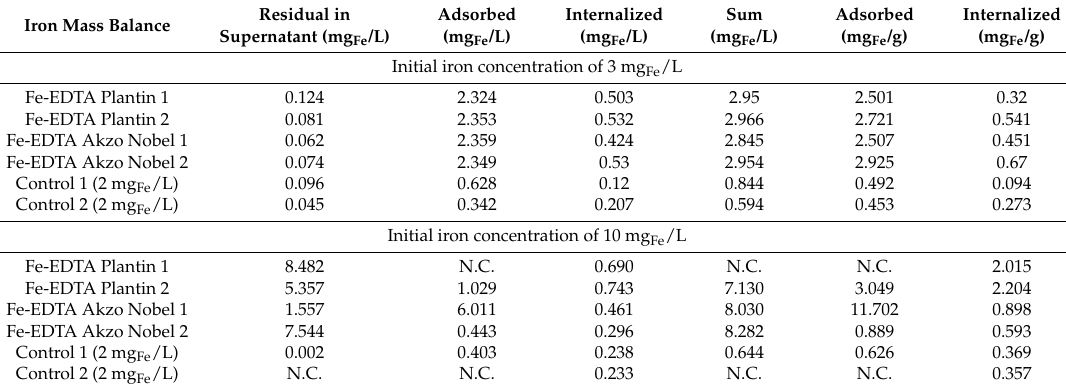
Table 4. Iron mass balance for the Spirulina cultivation experiments using Fe-EDTA formulations from Plantin and Akzo Nobel at 3 and 10 mg Fe /L of iron in comparison to the control, modified ZM.